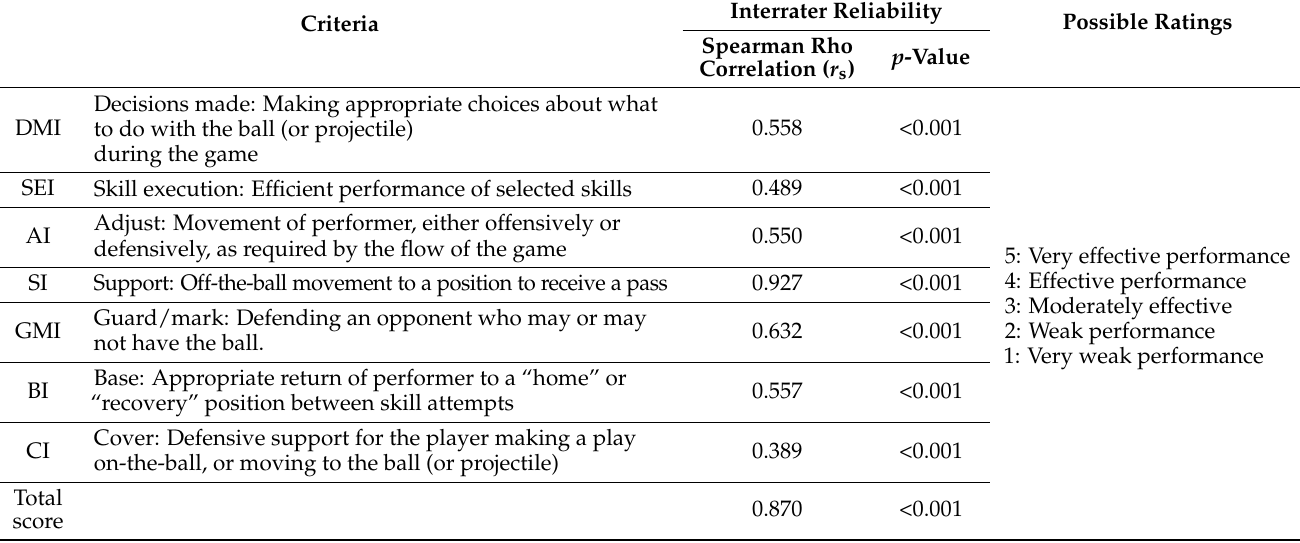
Table A2. This is a table. Tables should be placed in the main text near to the first time they are cited.